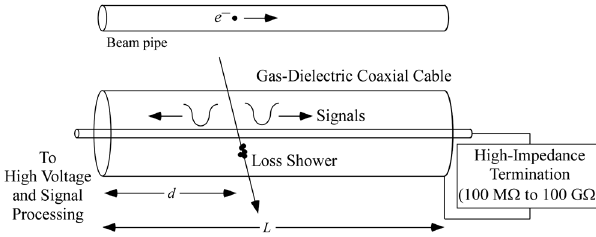
FIG. 3. Sketch of a LION. The nominal inner- and outer- conductor diameters are 18.1 and 46.5 mm, respectively.